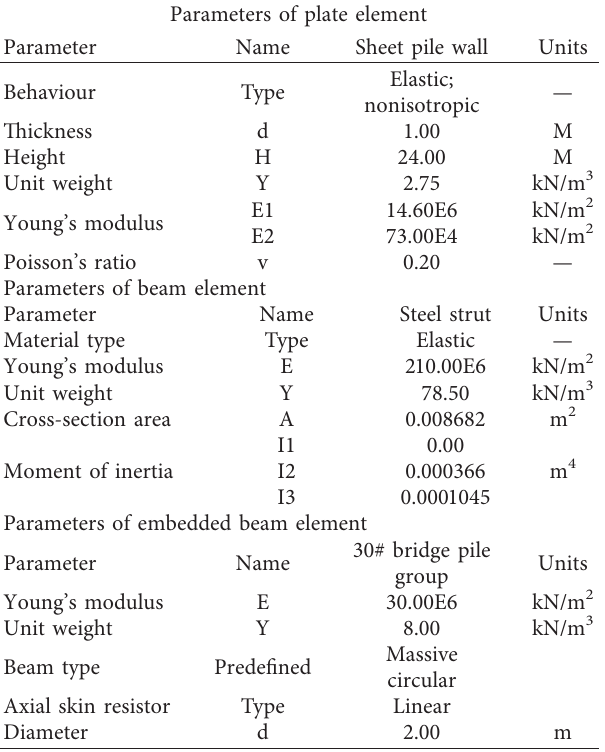
Table 3: Numerical model